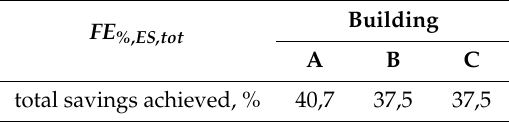
Total energy savings achieved through thermal improvement of buildings and of the introduction weather controlled central heating